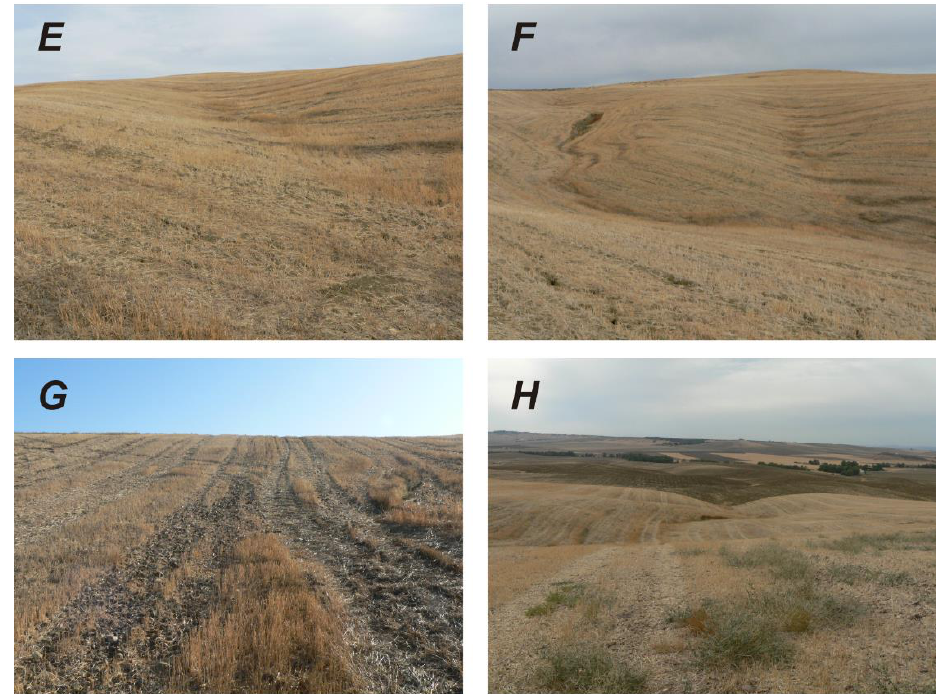
Figure 4. Field pictures of the studied areas. ( A , B ) View of the low section of catchment A and B, respectively. ( C , D ) Views of the mid-section of catchment A. ( E , F ) Headwater reaches in catchment A. ( G ) Upstream view from the head of the channel to the water divide (channel 44, catchment C). ( H ) Downstream view from the water divide of catchment A.